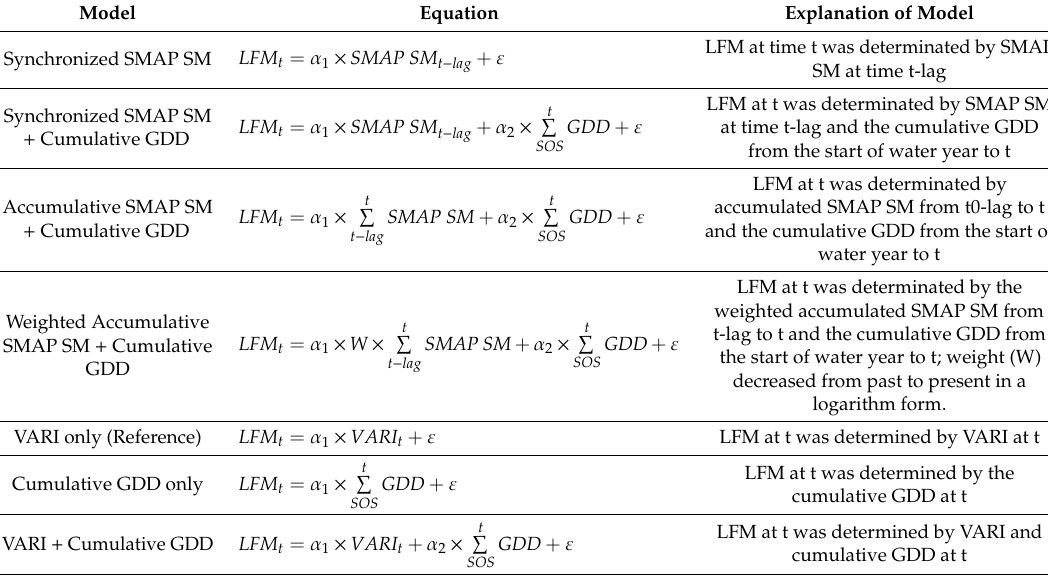
Table 1. Multi-variant regression models discussed in this study and the physical indication. Start of season (SOS) is defined as the first day when a consecutive increase of Visible Atmospheric Resistance Index (VARI)